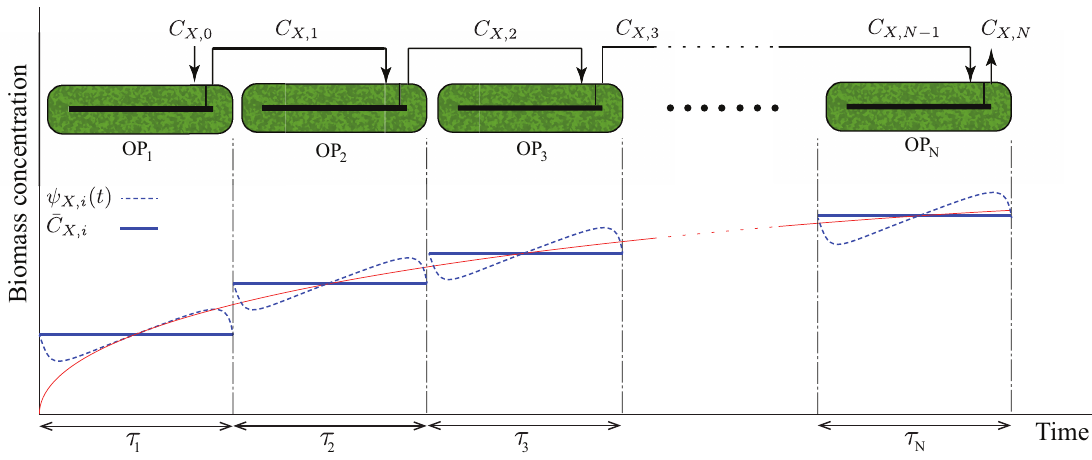
Figure 3. Periodic time-varying concentration scheme used as the basis of Optimization Strategy